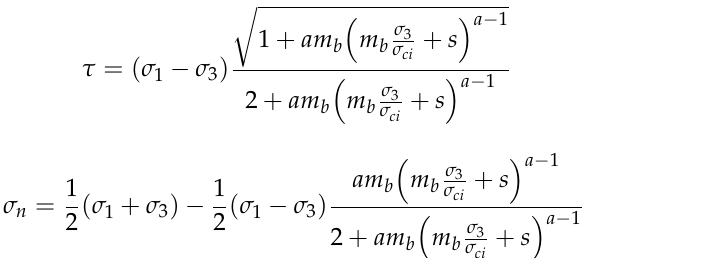
Figure 5. Model and boundary of slope section A ‐ A under